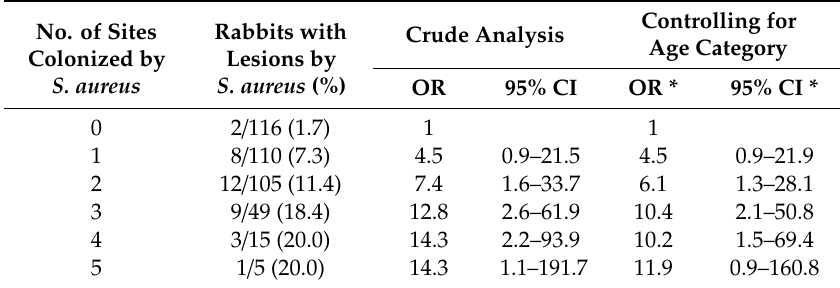
Table 2. Risk of having lesions due to S. aureus : Rabbits stratified by number of anatomical sites colonized by S. aureus